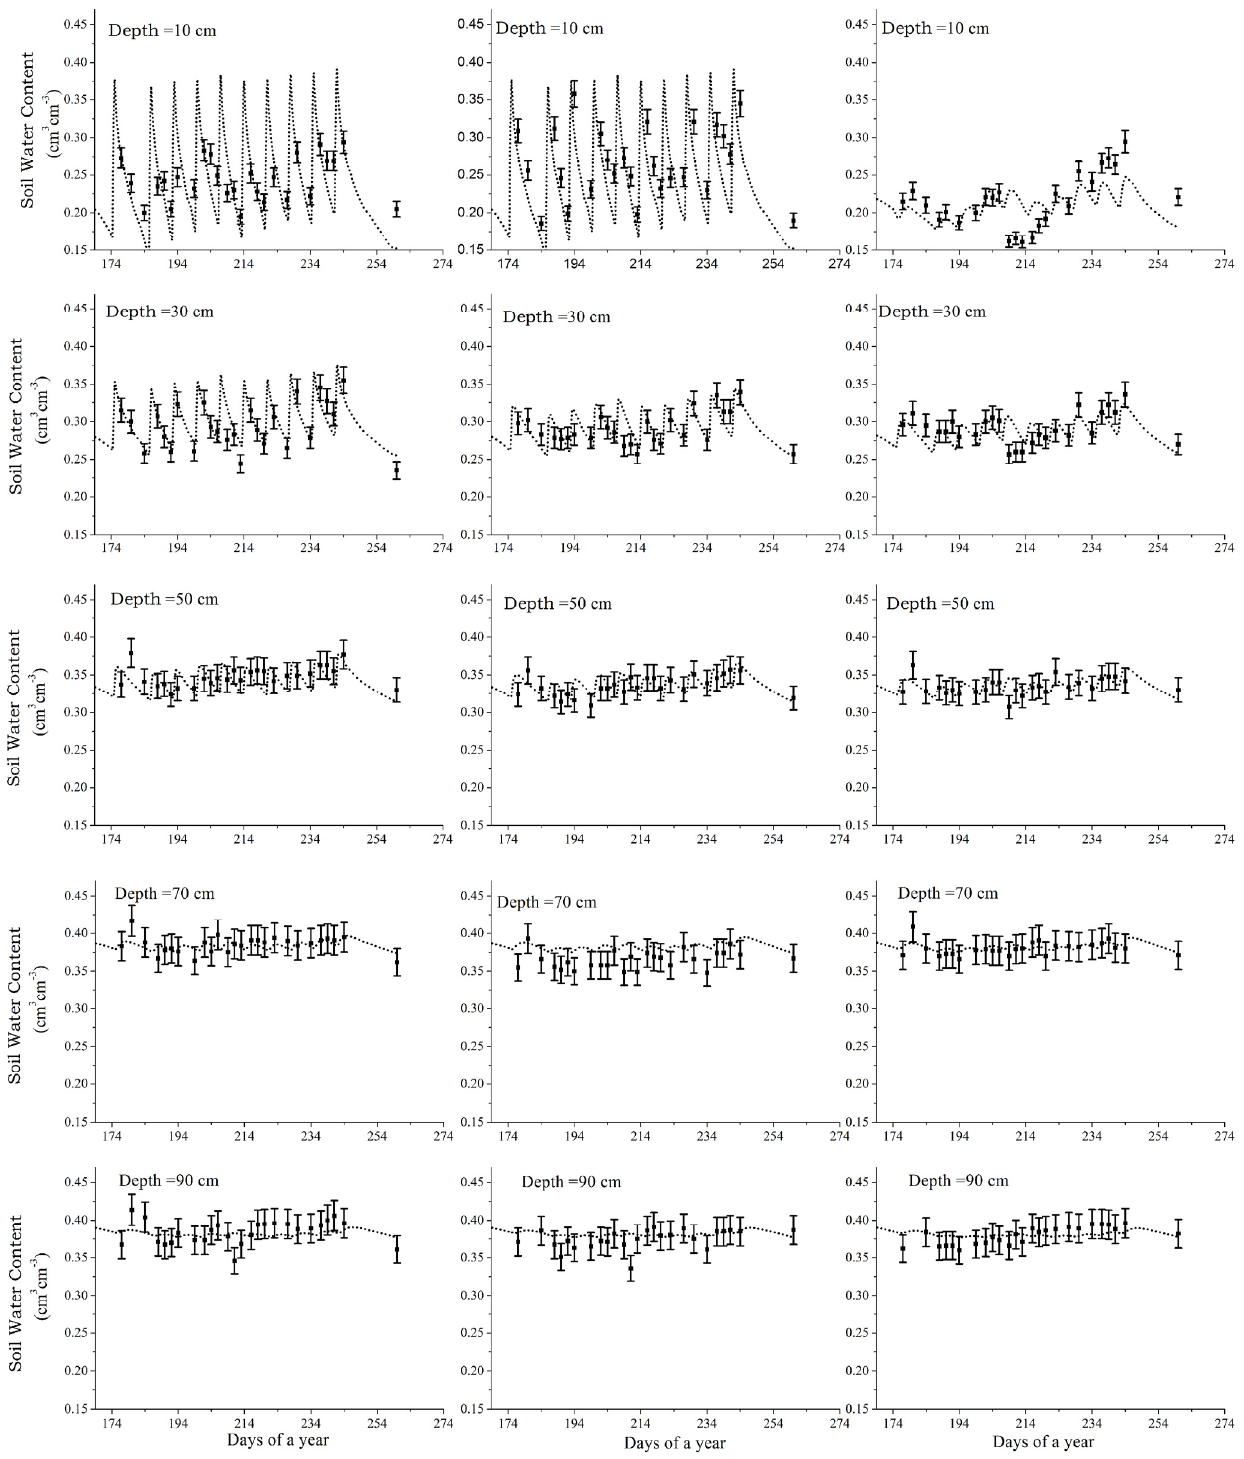
Figure 6. Simulated soil water contents (lines) and measurements (dots) at various depths in different observation locations for T2. The three columns of the plots represent the horizontal location: the left column of the plots for the observation point under drip line ( x = 4.03 cm), the middle column of the plots for the observation point under mulch ( x = 36.25 cm), and the right column of the plots for the observation point under exposed soil ( x = 68.47 cm). The five rows represent the following depths from the soil surface: 10, 30, 50, 70, and 90